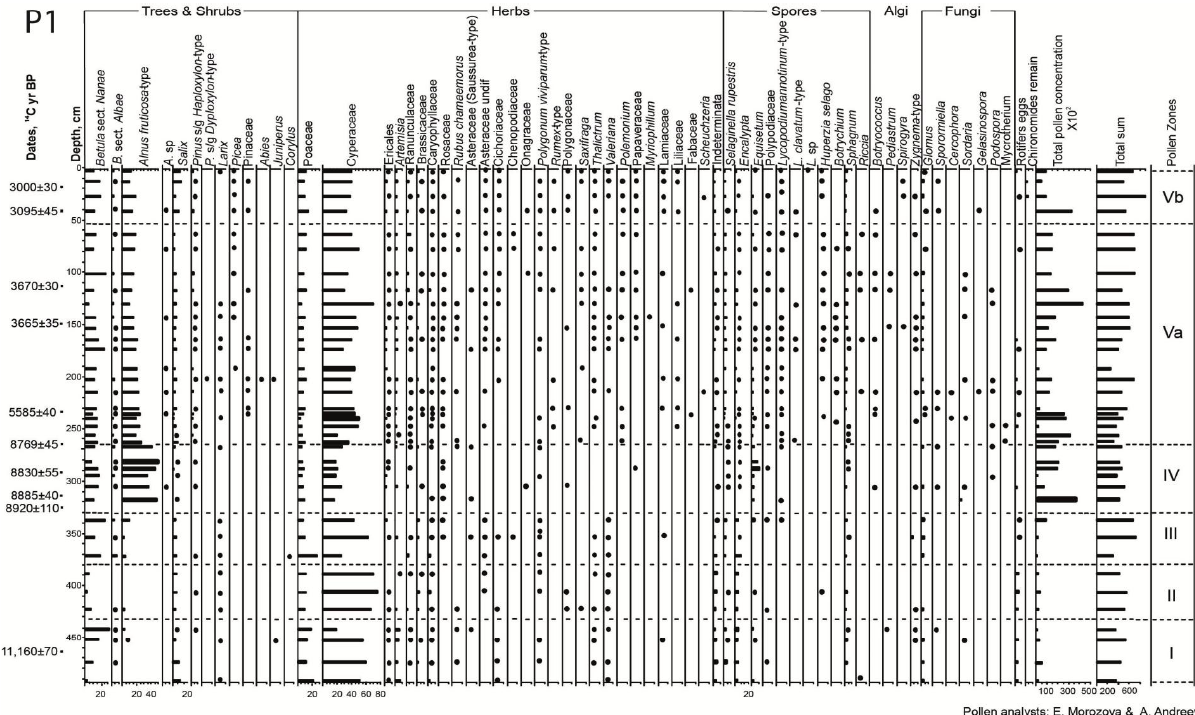
Fig. 3. Percentage pollen diagram of core P1. Dots are < 2% pollen contents.